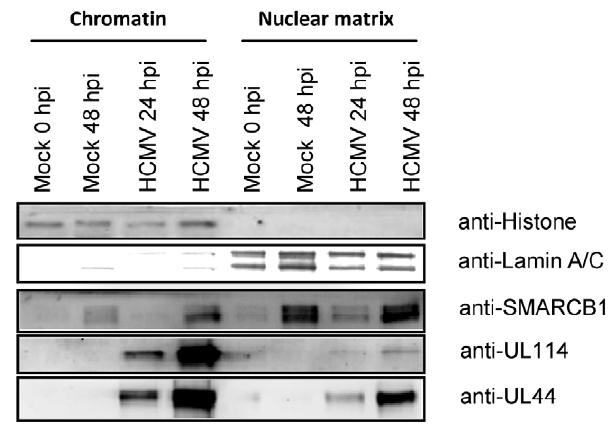
Figure 6. SMARCB1, UL114 and UL44 are associated with the chromatin and the nuclear matrix in HCMV infected fibroblast cells. Mock- and HCMV-infected fibroblast cells harvested at indicated time points were subjected to sub-nuclear fractionation to obtain whole chromatin fraction and core nuclear matrix. Proteins from equal cell equivalents from each fraction were analyzed by western blotting with the indicated antibodies.